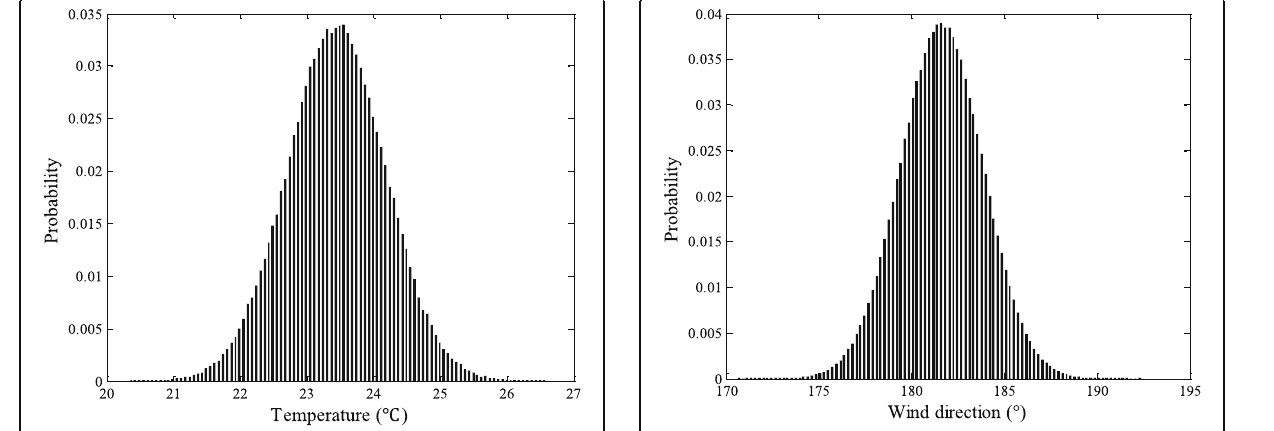
Fig. 5 Ambient temperature distribution histogram